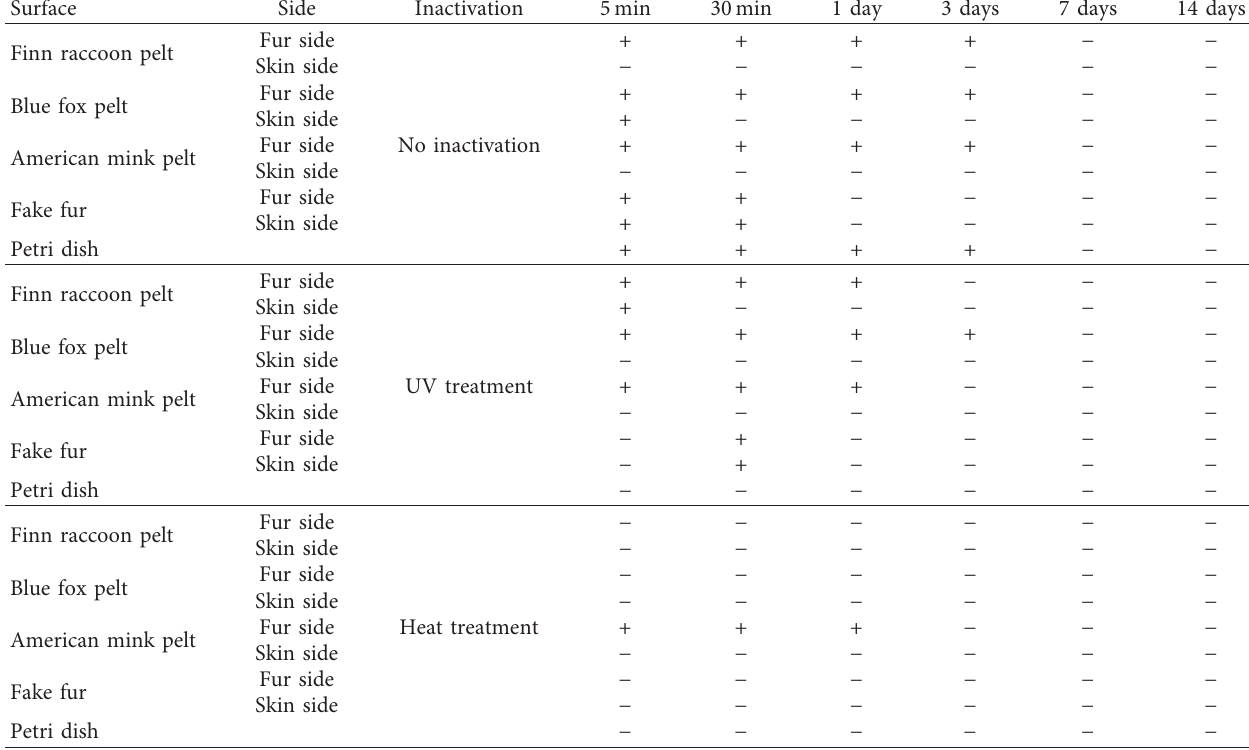
Table 1: Stability of SARS-CoV-2 on surfaces without inactivating treatment and after inactivating treatments under UV light for 5min and in 60 ° C water bath for 1h.